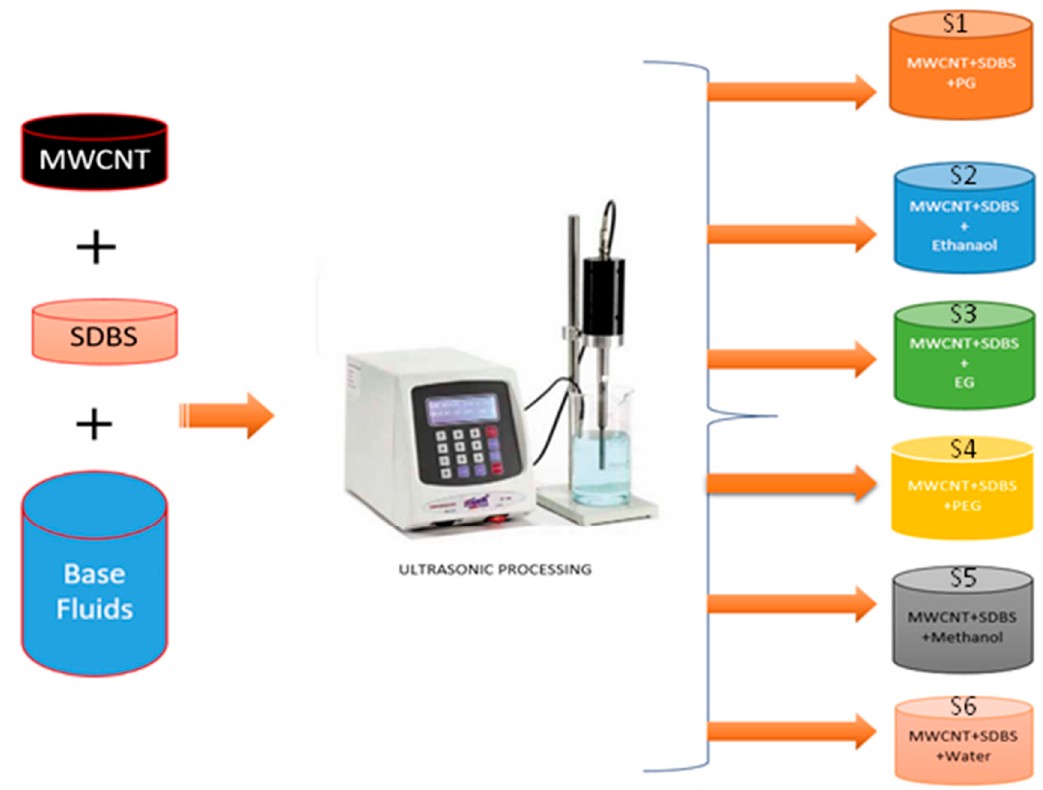
Figure 1. Preparation process of Multiwalled Carbon Nanotubes (MWCNTs) nanofluids.